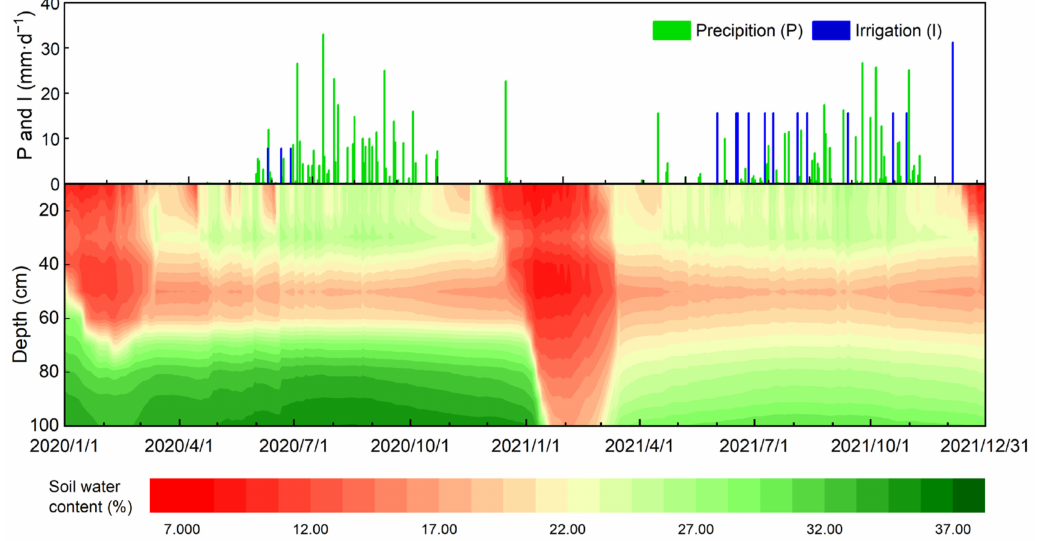
Figure 3. Variation of volumetric water content (VWC) in the 0–100 cm soil